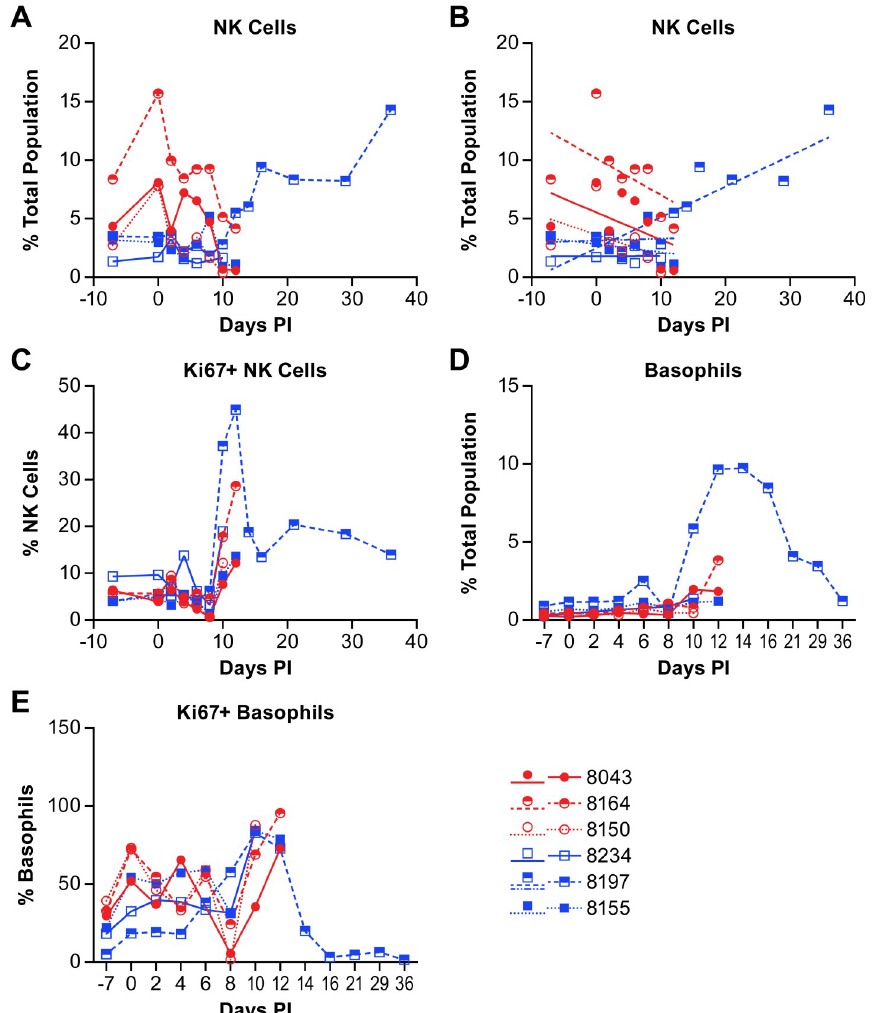
Fig 9. Changes in antigen presenting cell population in animals infected with NiV. The percent of monocytes (A), myeloid dendritic cells (mDC) (B) and plasmacytoid dendritic cells (pDC) (C) are shown as a function of the total population of analyzed cells from individual animals. Red circles indicate the low dose group and blue squares indicate the high dose group. The cell surface markers for defining individual populations is provided in S3